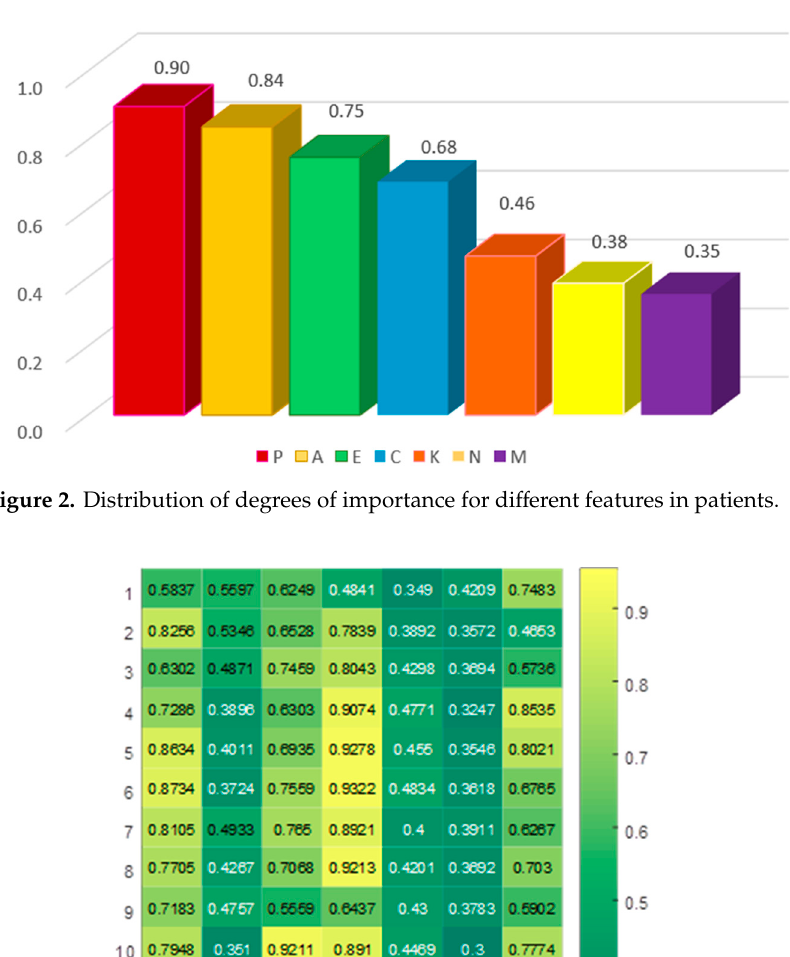
Table 3. Comparison of importance ranking of cancer features in patients for different weights in MIRSPSO.